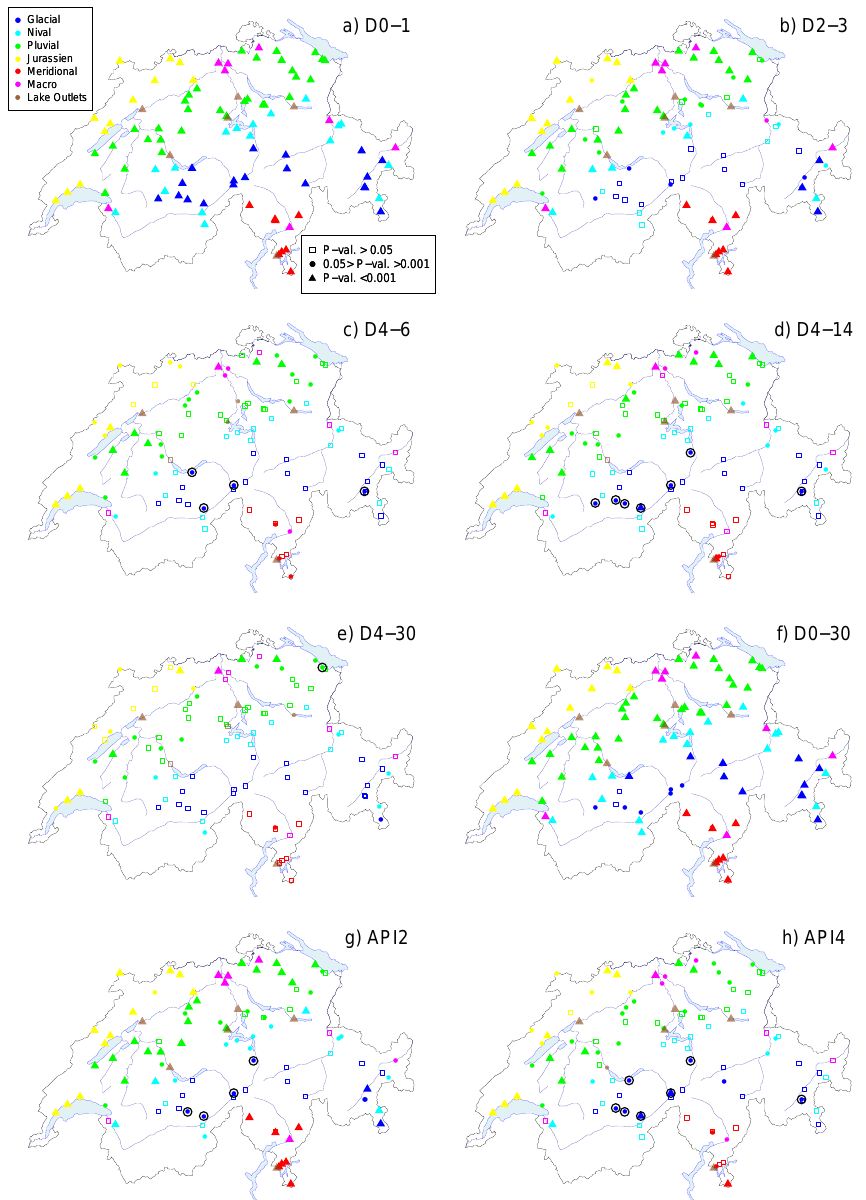
Figure 7. The relevance of the different precipitation periods for the occurrence of annual floods is tested using logistic regression for each precipitation period and each catchment (a) D0–1, (b) D2–3, (c) D4–6, (d) D4–14, (e) D4–30, (f) D0–30, (g) API2, and (h) API4. Several thresholds are tested (P50, P75, P90, P95, P99) and the most significant P value is displayed symbolically (squares, dots and triangles indicate a non-, weakly-, and strongly significant influence, respectively). The colors of the symbols refer to the hydrological regimes of the catchments. Circles denote a negatively significant correlation, i.e., the exceedance of a given precipitation threshold significantly reduces flood